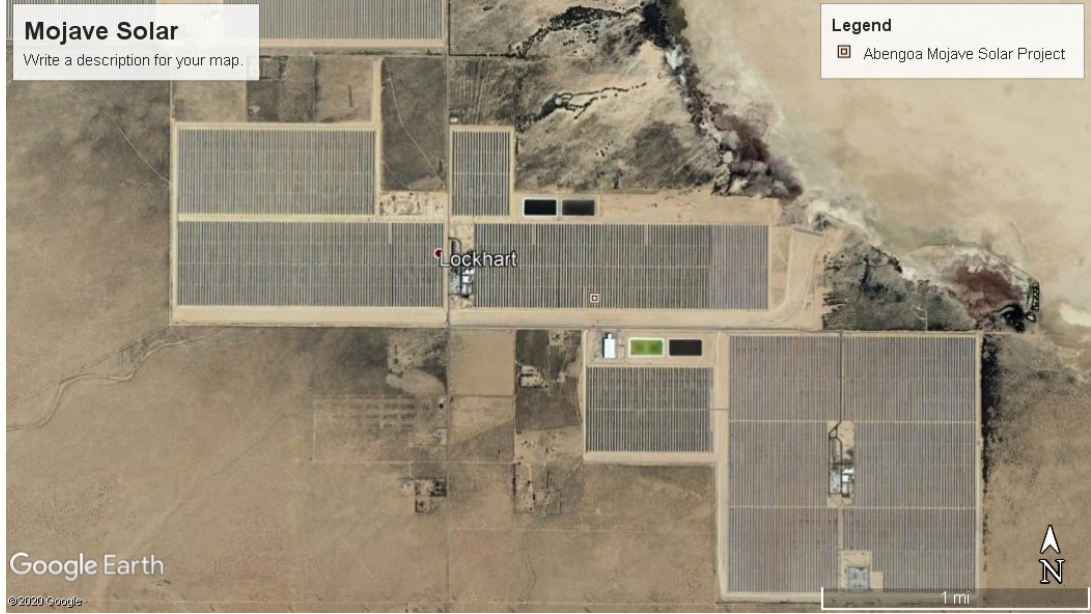
Table 2. Mojave Project specifications [38]